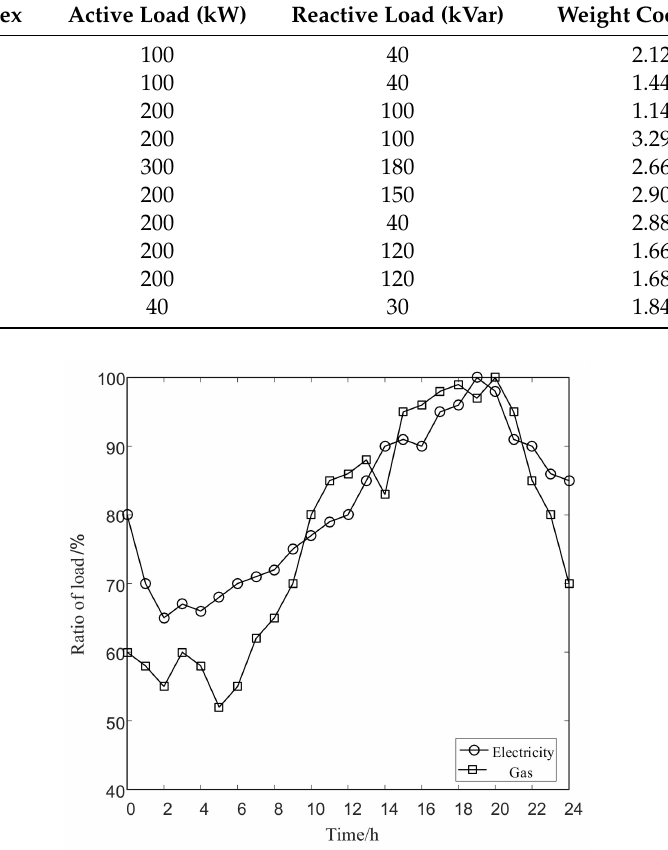
Table 2. Base electric loads.